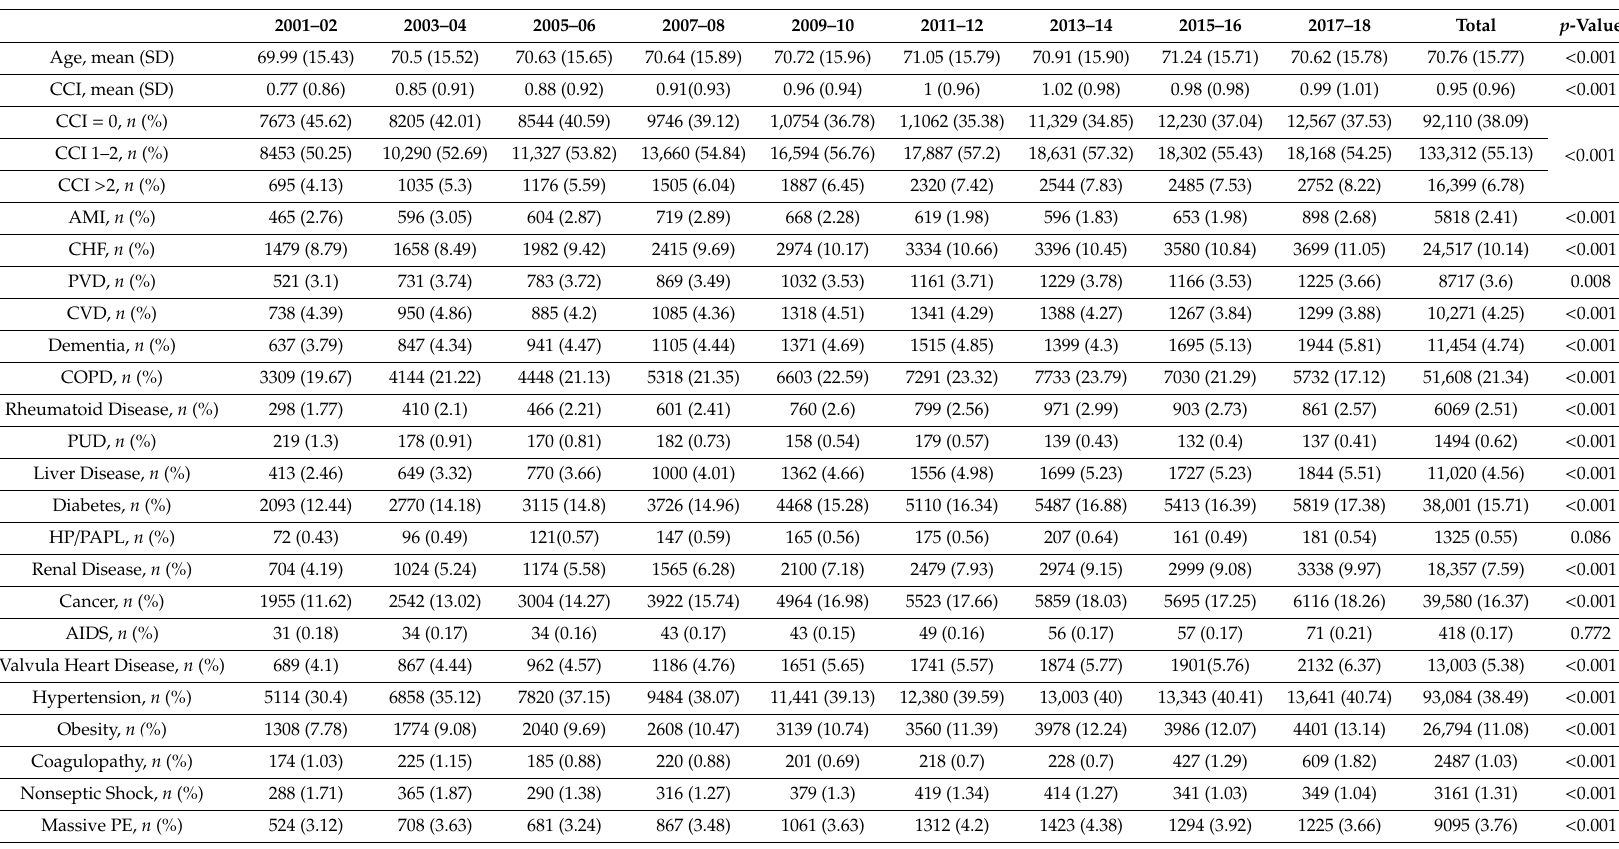
Table 2. Age, Charlson comorbidity index (CCI), and clinical characteristics of patients hospitalized with pulmonary embolism in Spain from 2001 to